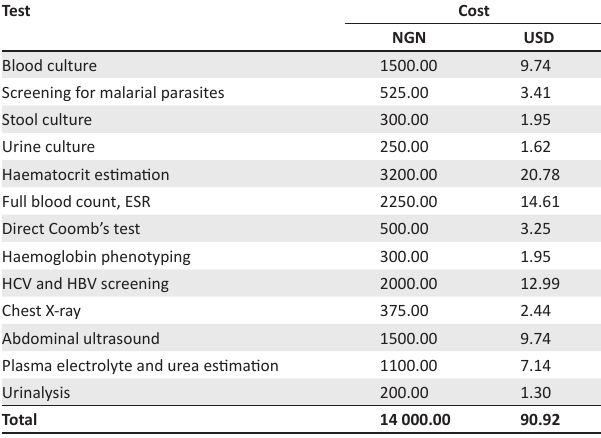
FIGURE 2: PCR amplification of a ctx allele from K. pneumoniae subsp . pneumoniae isolate K01 from this study. Lane 1: 1 kb Ladder plus (Invitrogen). Lane 2: K01. Lane 3: ESBL-negative E. coli strain 042. Lane 4: No template. Marker size fragments are indicated to the left of the gel in Kilobase pairs. In the absence of a positive control, the identity of the band amplified from strain K01 was determined by TABLE 3: Investigations.